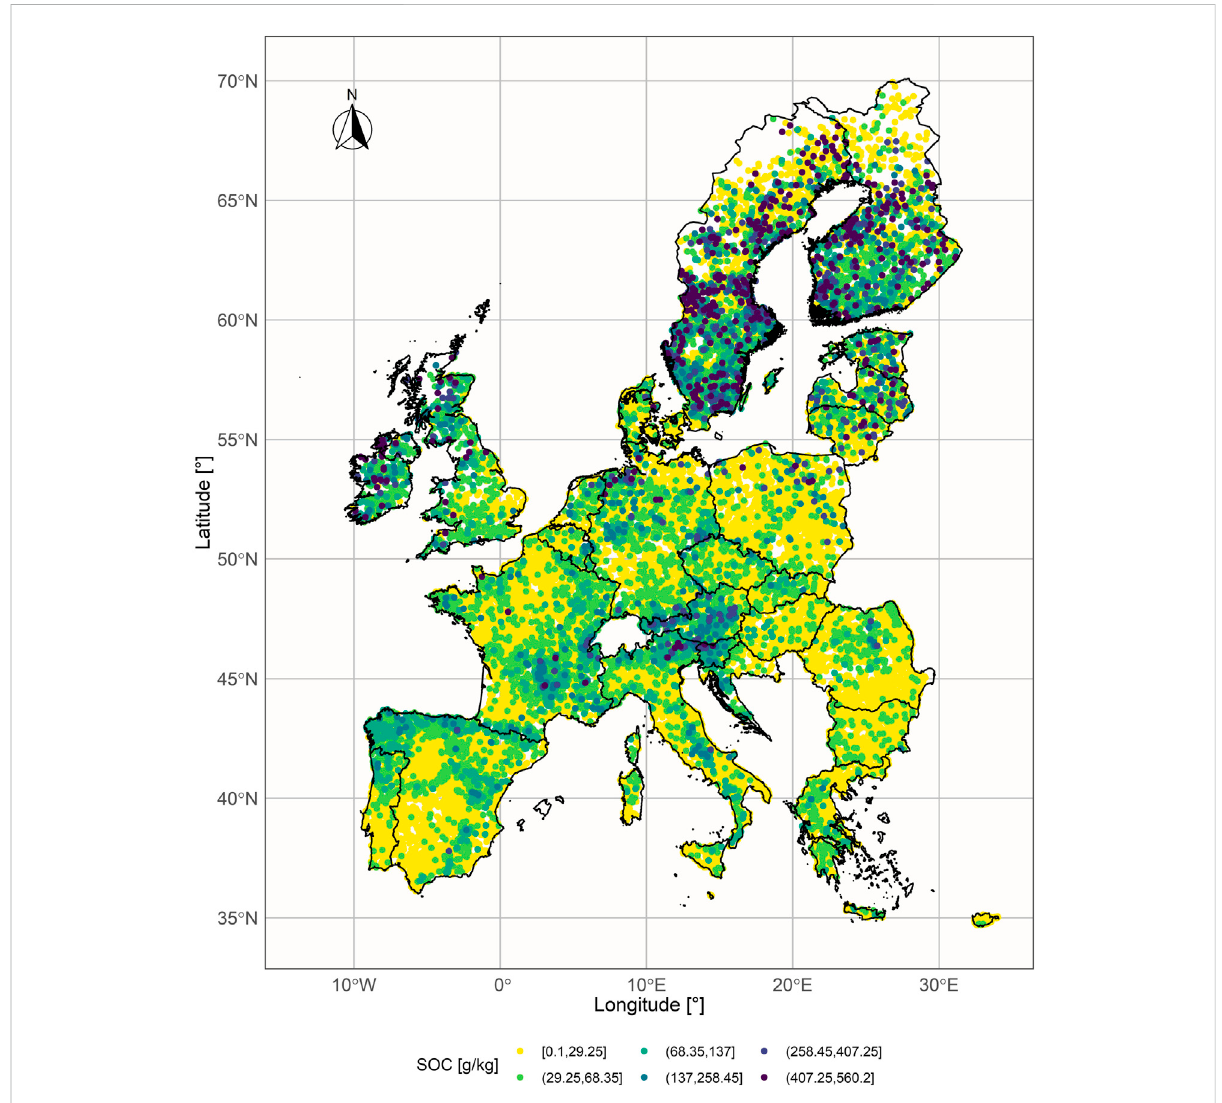
FIGURE 1 Spatial distribution of LUCAS samples and SOC values in [g/kg] for the year